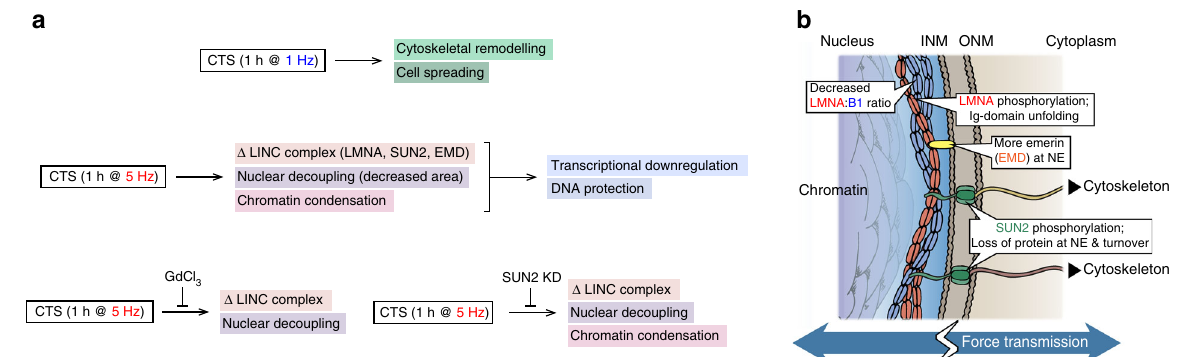
Fig. 10 Effects of cyclic tensile strain (CTS) on mesenchymal stem cell (MSC) behavior. a Schematic summarizing the responses of MSCs to low and high intensity CTS, and how these pathways depend on ion channel activity and SUN domain-containing protein 2 (SUN2). b Cartoon summarizing strain- induced changes to proteins in the linker of nucleoskeleton and cytoskeleton (LINC) complex and nuclear envelope (NE). ONM outer nuclear membrane; INM inner